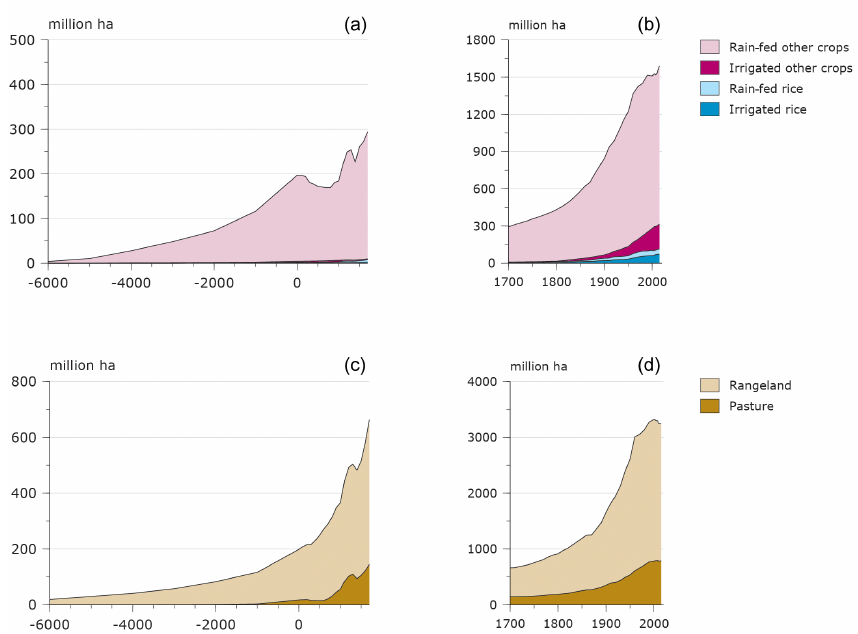
Figure 4. Summary of historical land use area estimates for different time periods. Cropland area for 6000BCE–1700CE (a) and 1700– 2010CE (b) . Grazing land area for 6000BCE–1700CE (c) and 1700–2010CE (d)